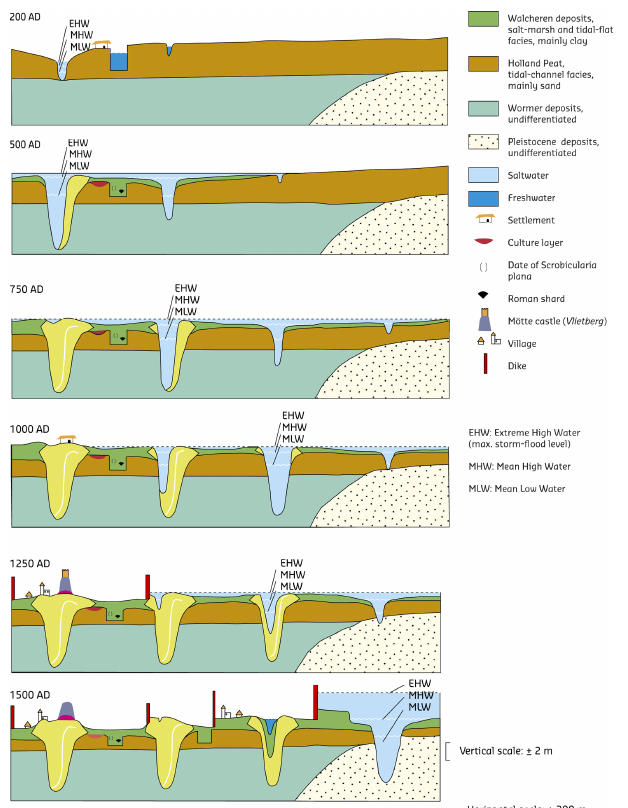
Figure 4. Schematic cross-section illustrating the interplay between tidal channels, embankments, subsidence, and water levels (from Vos,